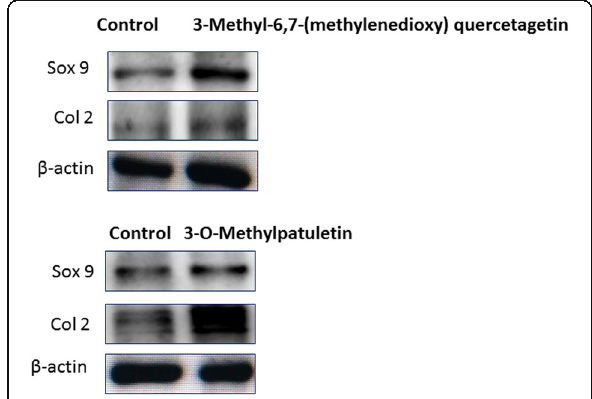
Fig. 2 Effect of SOE on chondrogenic proteins. Western blot analysis of Sox 9 and Col 2 after 3-Methyl-6,7-(methylenedioxy) quercetagetin, and 3- O-Methylpatuletin (active compounds extracted from SOE) is represented after treatment in rat articular chondrocytes isolated from 5 days old